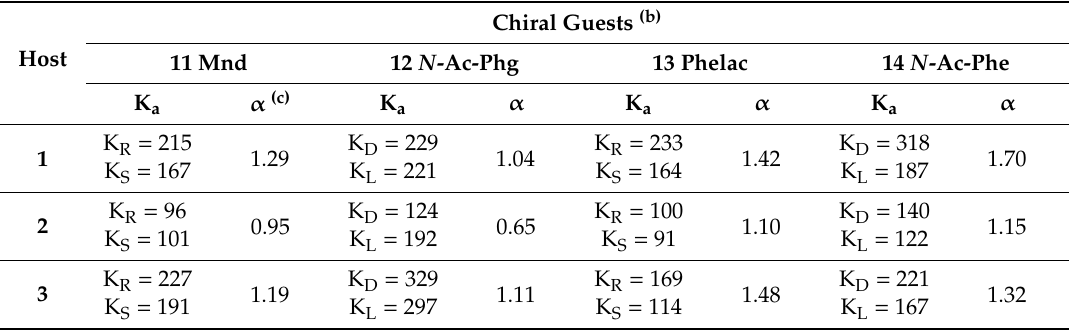
Table 2. Binding constants for the formation of 1:1 complexes of receptors ( R )- 1 – 3 with chiral